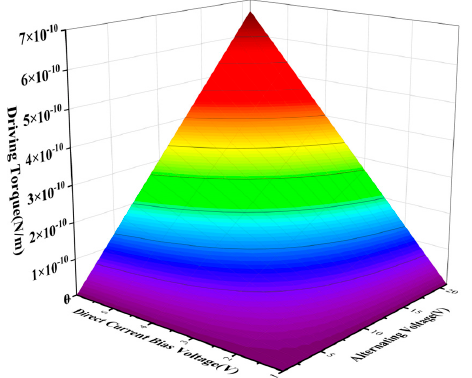
Figure 15. Electrostatic driving torque curve.